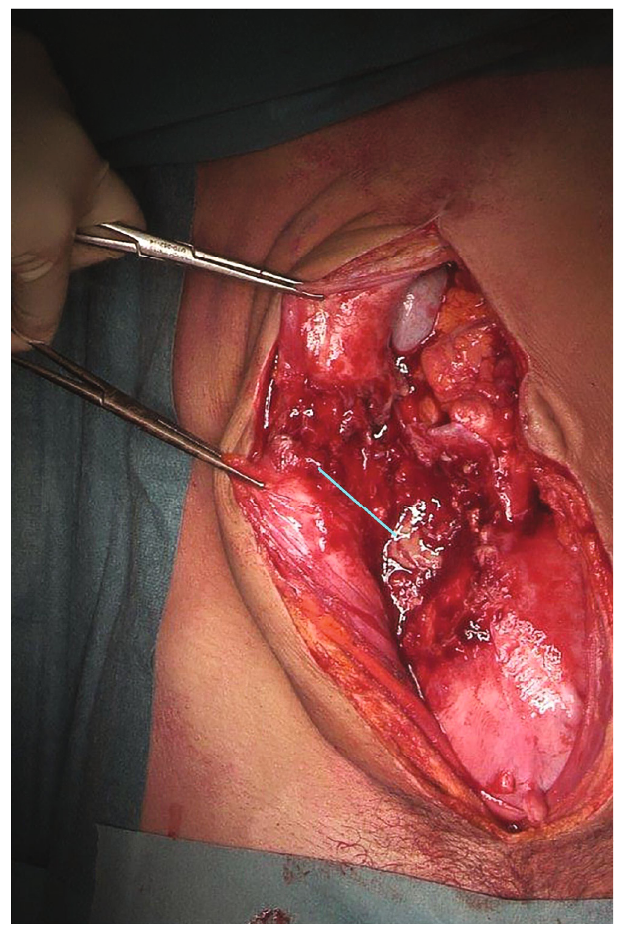
Figure 3: The blue arrow shows fi stulae ’ s tract (from the right uterine fundus to the skin) after its excision, before hysterectomy. The green star shows the